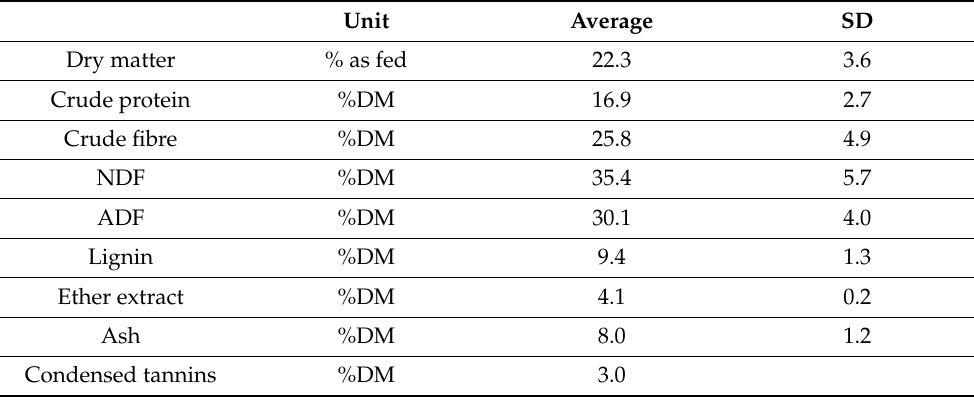
Table 9. Nutritional value of Onobrychis viciifolia Scop [190].